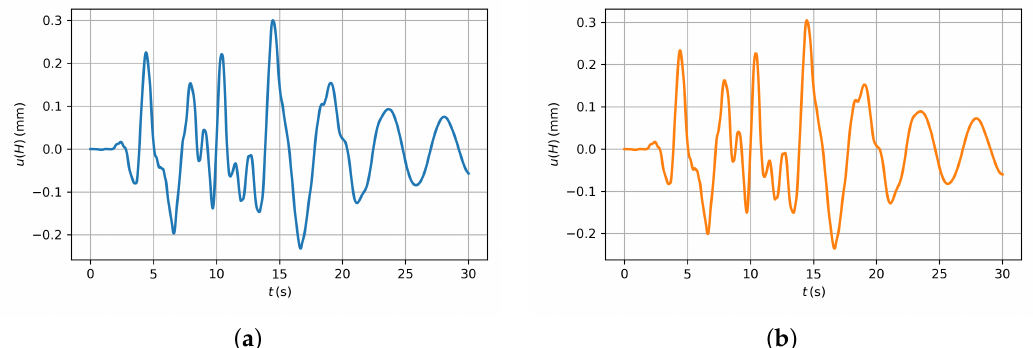
Figure 5. Top-level displacement in x direction in the detailed FE model ( a ) and in the e-TBM ( b ).